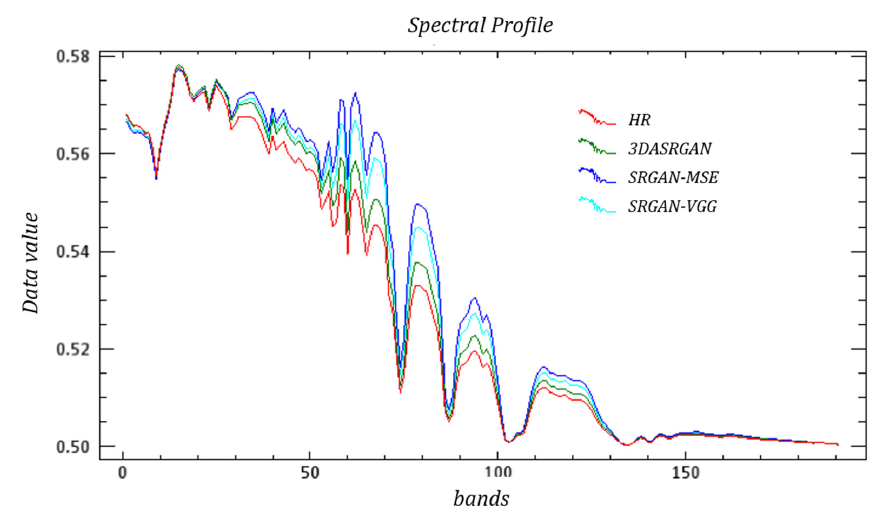
Figure 19. Example Spectral Curves of Road based on the Washington DC Mall dataset.